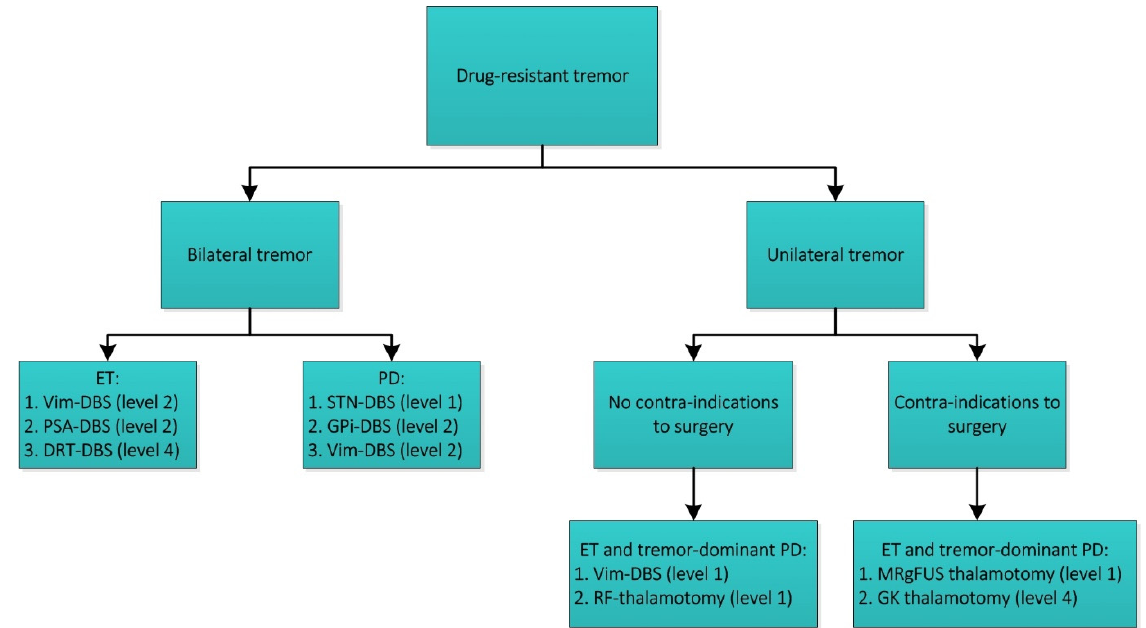
Figure 2. Surgical treatment options for patients affected by drug-resistant tremor. The levels correspond to the level of evidence according to the Oxford Centre for Evidence-Based Medicine 2011. DBS: deep brain stimulation, ET: essential tremor, PD: Parkinson’s disease, Vim: ventral intermediate nucleus of the thalamus, PSA: posterior subthalamic area, DRT: dentato-rubro-thalamic tract, STN: subthalamic nucleus, GPi: internal pallidum. RF-thalamotomy: radiofrequency thalamotomy. MRgFUS: MRI-guided focused ultrasound. GK: gamma knife